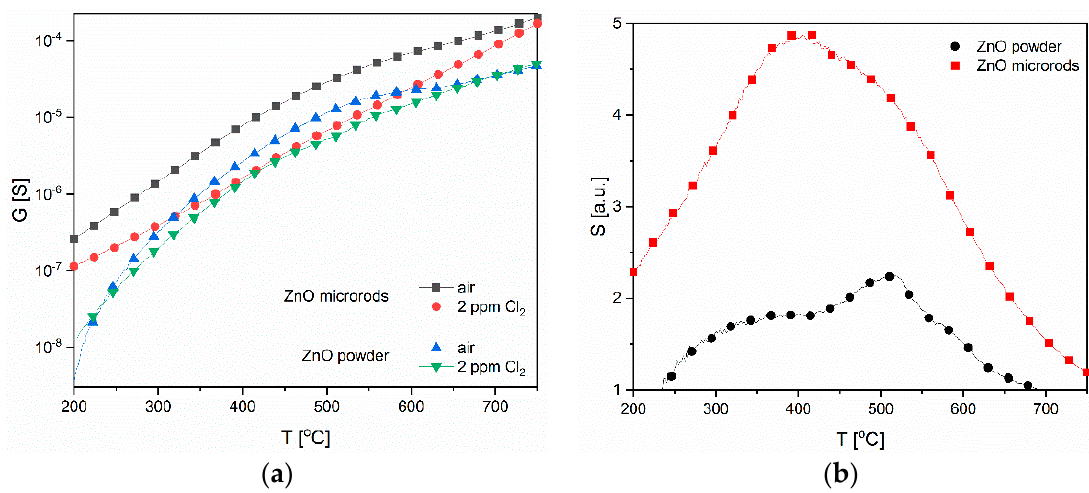
Figure 8. Temperature changes of: ( a ) conductance; ( b ) sensitivity to Cl 2 of the sensors.